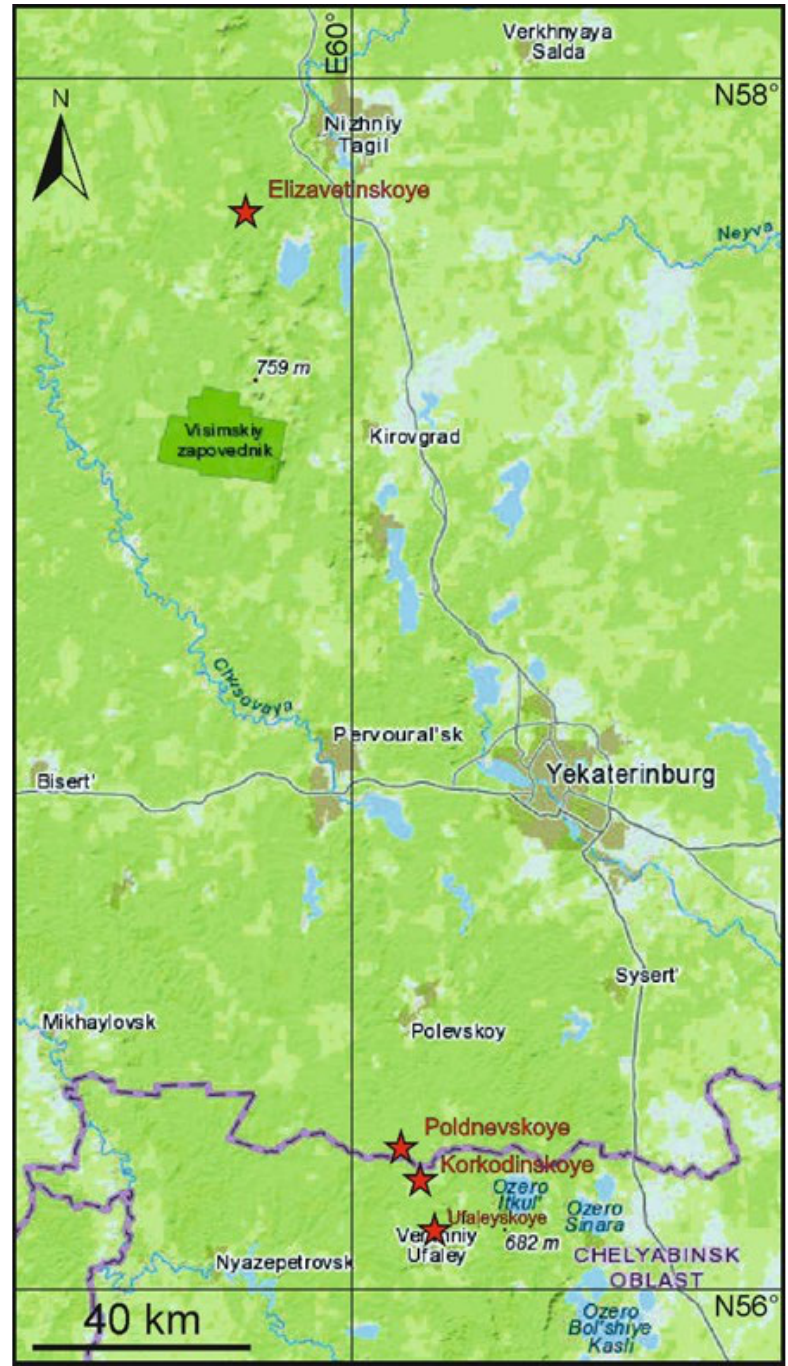
Figure 1. Geographic position of the demantoid deposits in the Central Urals. At present, the gem demantoids related to (1) the massif of ultrabasic rocks (the Urals type) and (2) the skarns (the Namibian type) are recognized. The Ural demantoids are characterized by horsetail inclusions, which are hair-like inclusions that diverge in